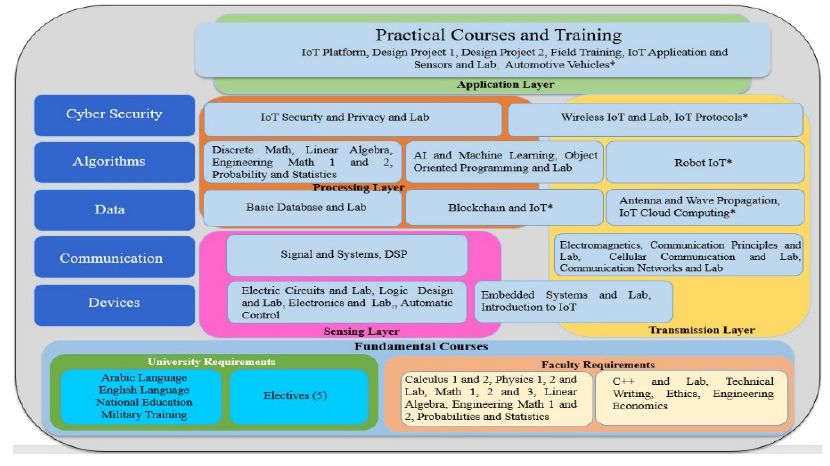
Fig. 3. The technical knowledge map of IoT